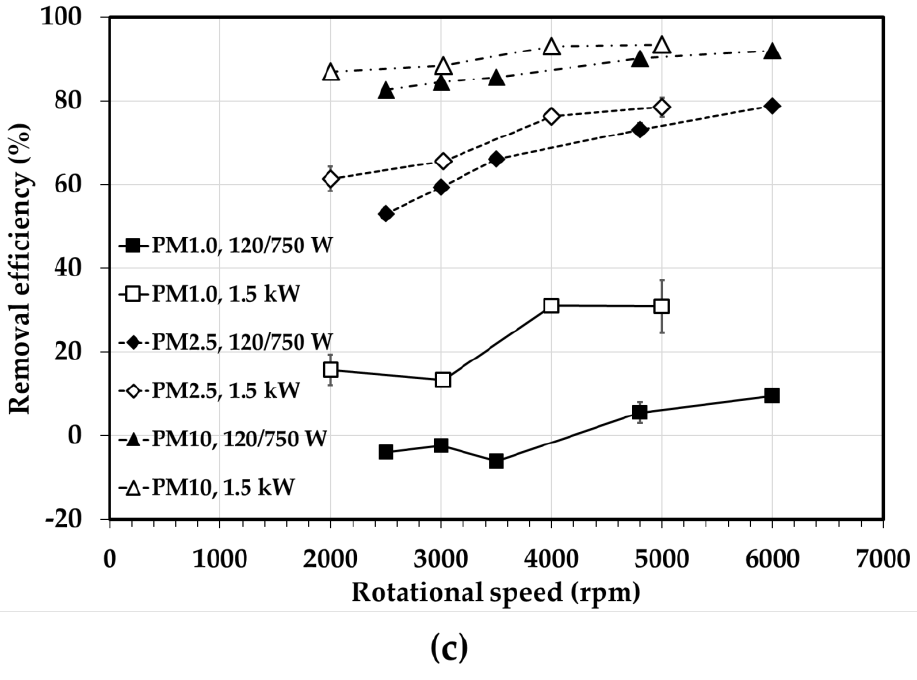
Figure 6. Oil-mist-removal efficiencies according to rpm: ( a ) 120 W motor; ( b ) 1.5 kW motor; ( c ) PM 1.0 , PM 2.5 , and PM 10 removal efficiencies at different rpm values.